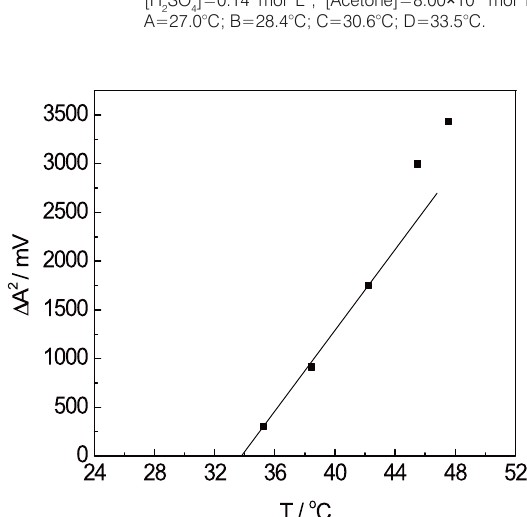
Figure 2. Bifurcation profiles using temperature as control parameter. Conditions: [MnSO